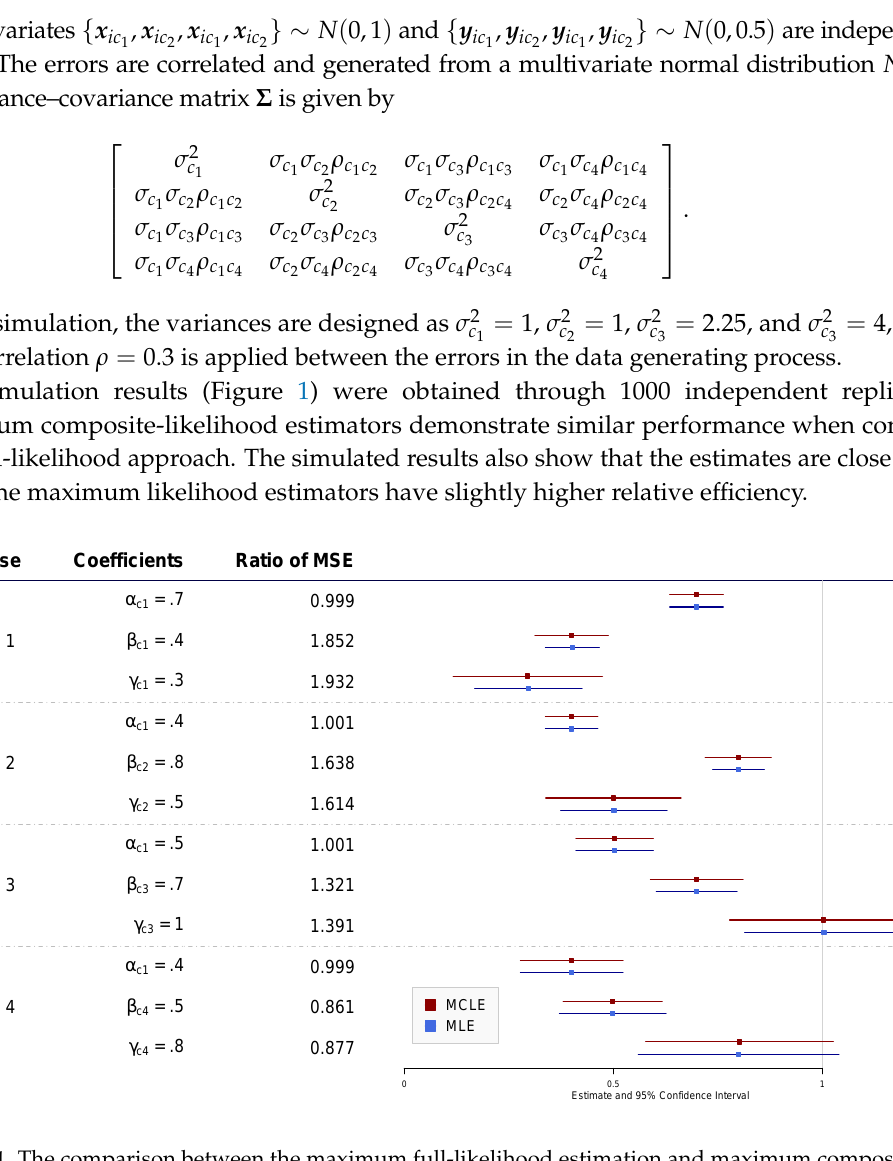
Figure 1. The comparison between the maximum full-likelihood estimation and maximum composite- likelihood estimation for the regression coefficients on the multivariate continuous outcomes. The ratio of the mean squared error (MSE) was computed using the MSE of the maximum composite-likelihood estimate (MCLE) over the MSE of the maximum likelihood estimate